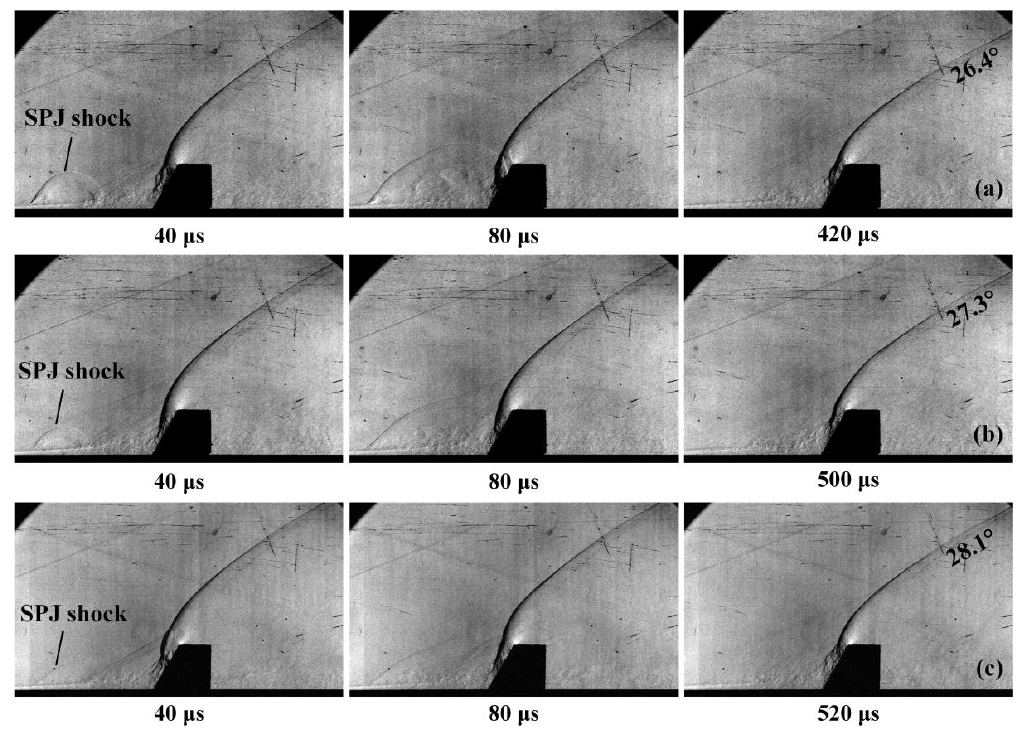
Figure 6. Comparison of the flow field evolution process with different discharge capacitance: ( a ) case1—640 nF, ( b ) case2—320 nF and ( c ) case3—80 nF.